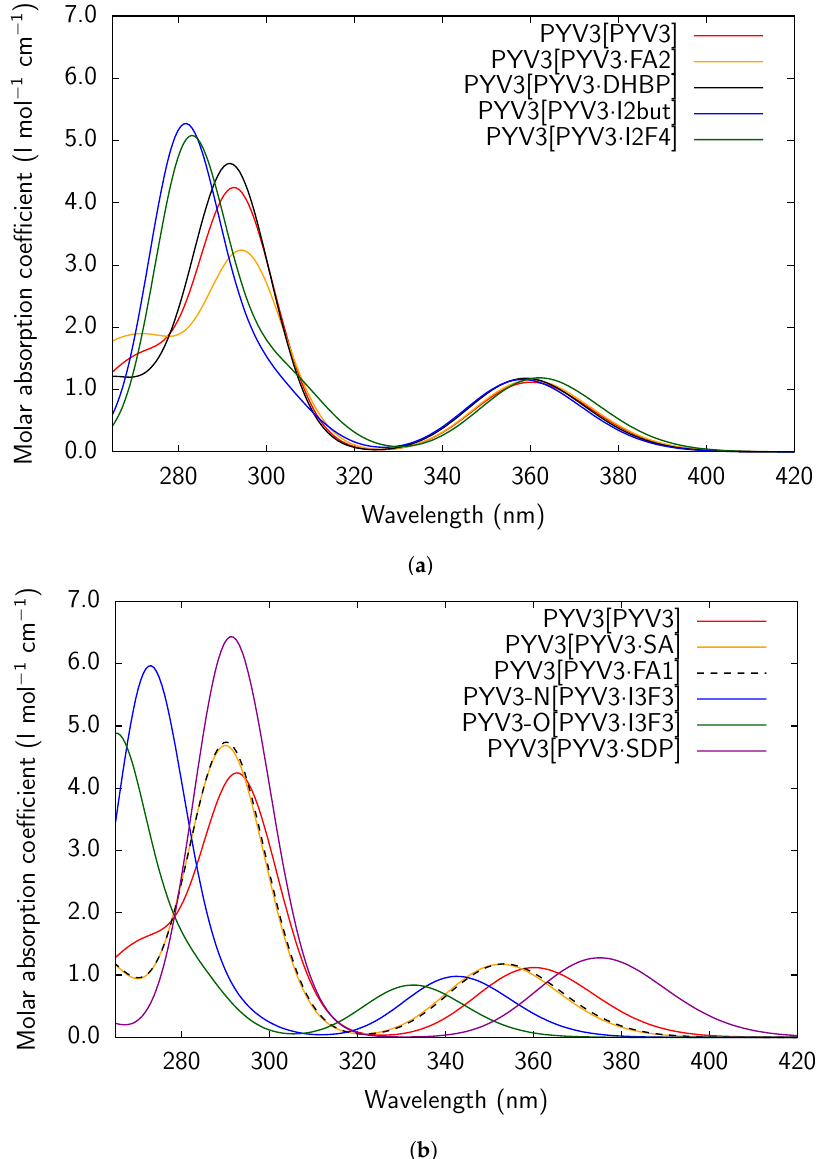
Figure 2. RI-CC2/def2-TZVPD UV/Vis absorption spectra of isolated monomers of all-enol crystals (PYV3 [PYV3 · XXX]). For clarity, the spectra have been splitted in two parts, see ( a ) and ( b